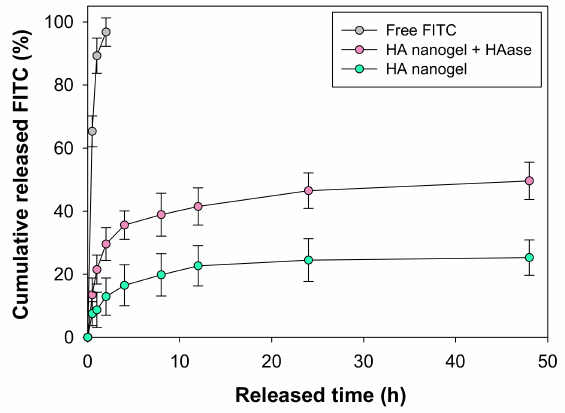
Figure 3. In vitro release test of FITC-encapsulating HA nanogel for 48